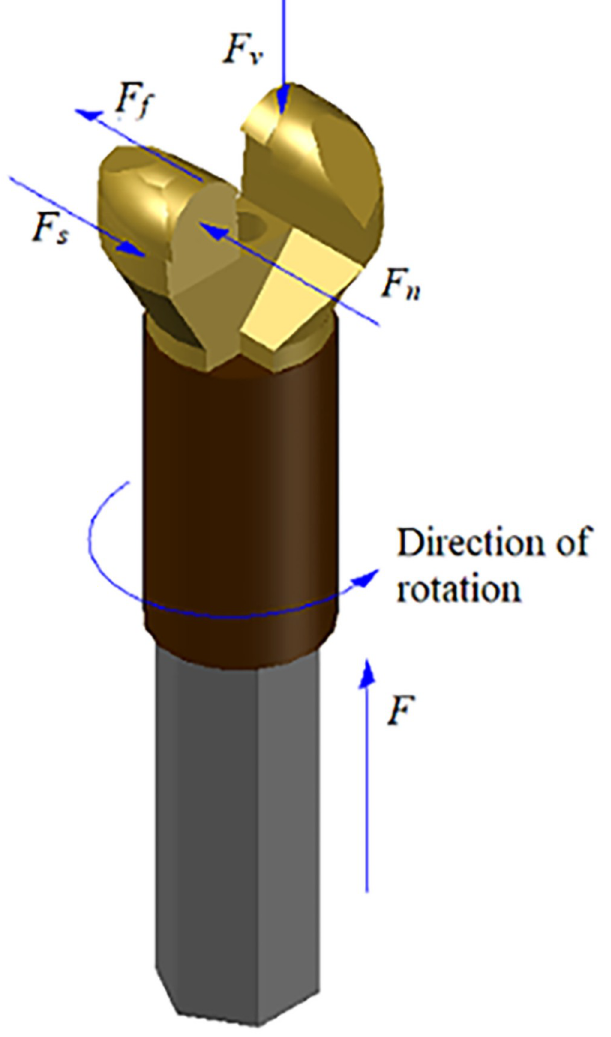
Fig 10. Mechanical model of drill